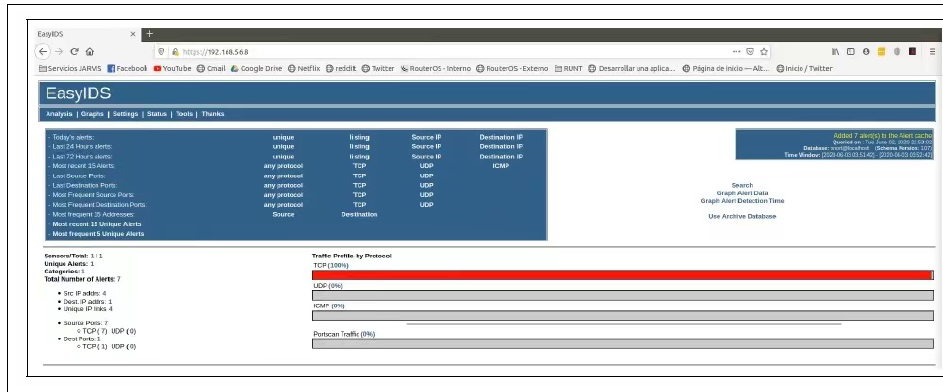
Figure 6. Snort DoS attack result.